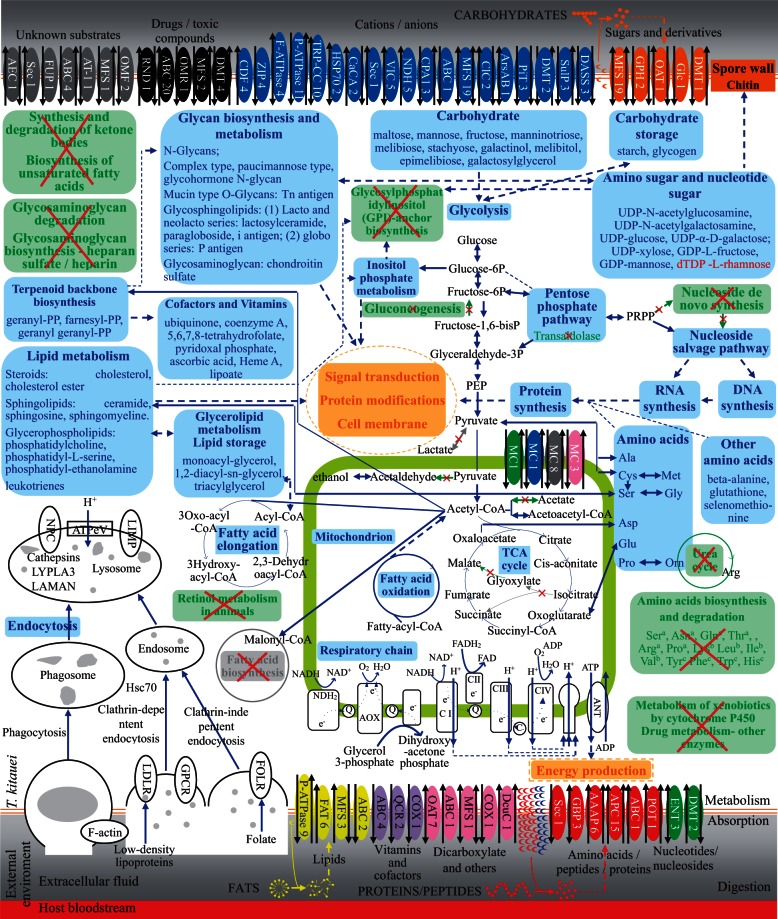
An overview of nutrient digestion, absorption and metabolism in T. kitauei, as deduced from genome sequence analysis. The color-coding in the secretory digestive enzymes of T. kitauei: red, proteases; blue, proline iminopeptides; orange, carbohydrate-binding module family proteins and glycoside hydrolases; yellow, lipase. Transporters are grouped by substrate specificity: red, amino acids/peptides/proteins; orange, sugars and derivative; yellow, lipids; green, nucleotides/nucleosides; purple, vitamins and cofactors; pink, dicarboxylates and others organic; blue, cations and anions; black, drugs/toxic compounds; gray, unknown substrates; numbers indicated the number of predicted transporters of each type. The color-coding in metabolism of T. kitauei indicates: blue, enzymes or pathways present in all three species, T. kitauei, H. magnipapillata, and N. vectensis; green with a cross, enzymes or pathways present in at least one of the two free-living cnidarians but absent in T. kitauei; gray with a cross, enzymes or pathways absent in all three species; red, enzymes or pathways present only in T. kitauei; orange, putative functions. Amino acids that can be de novo synthesized and catabolized (a) or partially synthesized and catabolized (b) or only catabolized (c) by the two free-living cnidarians. Unbroken arrows indicate direct steps in a pathway, and broken arrows indicate multiple steps in a pathway not shown. Amino acids are indicated in the three letter code. AAAP, amino acid/auxin permease; APC, amino acid-polyamine-organocation family; ArsAB, arsenite-antimonite efflux family; ABC, ATP-binding cassette superfamily; AT-1, autotransporter-1; AEC, auxin efflux carrier; DcuC, C4-dicarboxylate uptake C; CaCA, Ca2+:cation antiporter family; Hsp70, cation channel-forming heat shock protein-70 family; CDF, cation diffusion facilitator; ClC, chloride carrier/channel family; DASS, divalent anion: Na+ symporter; DMT, drug/metabolite transporter; ENT, equilibrative nucleoside transporter; GBP, general bacterial porin; Sec, general secretory pathway family; GPH, glycoside-pentoside-hexuronide: cation symporter; F-ATPase, H+- or Na+-translocating F-type, V-type and A-type ATPase; PiT, inorganic phosphate transporter; MFS, major facilitator superfamily; MC, mitochondrial carrier; CPA1, monovalent cation: proton antiporter-1; OAT, organo anion transporter; OMF, outer membrane factor; FUP, outer membrane fimbrial usher porin family; OMR, outer membrane receptor; FAT, proposed fatty acid transporter; POT, proton-dependent oligopeptide transporter; COX, proton-translocating cytochrome oxidase; NDH, proton-translocating NADH dehydrogenase; QCR, proton-translocating quinol: cytochrome c reductase; Glc, PTS glucose-glucoside; P-ATPase, P-type ATPase; RND, resistance-nodulation-cell division; SulP, sulfate permease; TRP-CC, transient receptor potential Ca2+ channel; VIC, voltage-gated ion channel; ZIP, zinc (Zn2+)-iron (Fe2+) permease; PEP, phosphoenolpyruvic acid; NADH, nicotinamide adenine dinucleotide; Q, quinine; AOX, alternative oxidase; CI to CIV, complex I to complex IV; C, cytochrome c; ANT, adenine nucleotide translocator; FAD, flavin adenine dinucleotide; FADH2, reduced FAD; ADP, adenosine diphosphate; FOLR, folate receptor; GPCR, G protein-coupled receptors; LDLR, low-density lipoprotein receptor; Hsc70, heat shock 70 kDa protein 1/8; ATPev, V-type H+-transporting ATPase; LIMP, lysosomal integral membrane protein; NPC, niemann-pick C protein; LYPLA3, lysophospholipase III; LAMAN, lysosomal alpha-mannosidase; F-actin, actin beta/gamma 1; TCA, tricarboxylic acid.